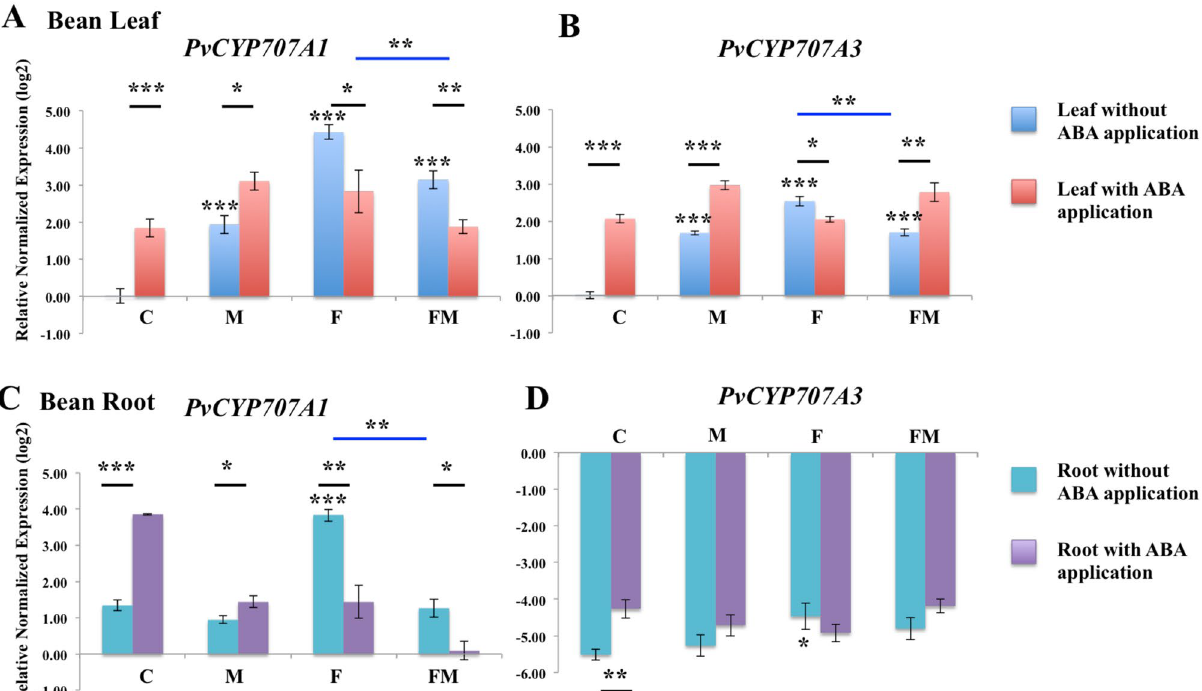
Figure 3. Relative expression of genes involved in the ABA catabolic pathway in bean leaves ( A , B ) and roots ( C , D ). RNA was extracted at 14 days bean leaves and root in un-inoculated control (C), colonized by M. robertsii (M), F. solani (F), and M. robertsii together with F. solani (FM). For each gene, the expression level in un-inoculated control bean leaf was set to 1. Standard errors are shown. Data were analyzed with standard t -test in Bio-Rad CFX Manager software. Statistical differences are shown; * P < 0.05, ** P < 0.01, *** P < 0.001. Asterisk alone indicates significant differences in gene expression in the tested group when compared to that of the un-inoculated control. Asterisk above the black line indicates significant differences in gene expression in the plant with exogenous ABA application compared to the corresponding plant without ABA application. Asterisk above blue line indicates significant difference in gene expression in the plant co-colonized by M. robertsii and F. solani compared to that in the plant colonized only by F. solani or M. robertsii . ABA 8 ′ -hydroxylase